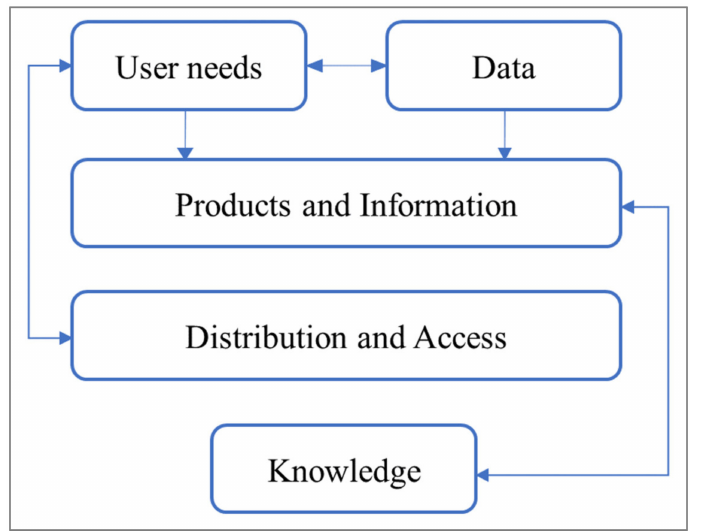
Figure 2. Schematic of the iterative steps GEO AquaWatch has developed to transform stakeholder needs into actionable